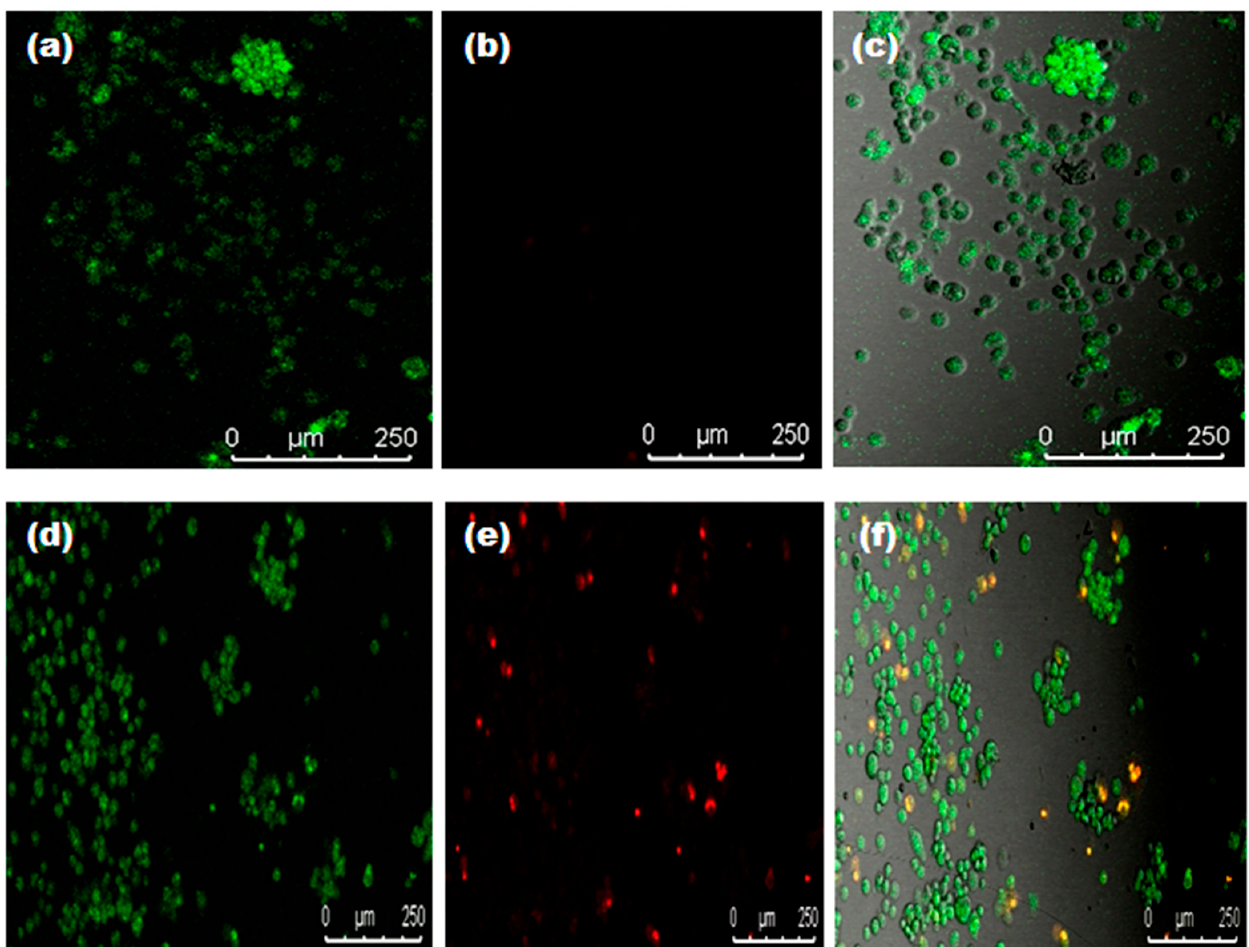
Figure 12. Confocal images of U87-MG cells at the IC 50 concentration of Diospyros malabarica extract mediated green synthesized AgNPs incubated for 4 h. ( a ) TO, ( b ) PI, ( c ) superimposed image of untreated; ( d ) TO, ( e ) PI, ( f ) superimposed image treated with AgNPs.